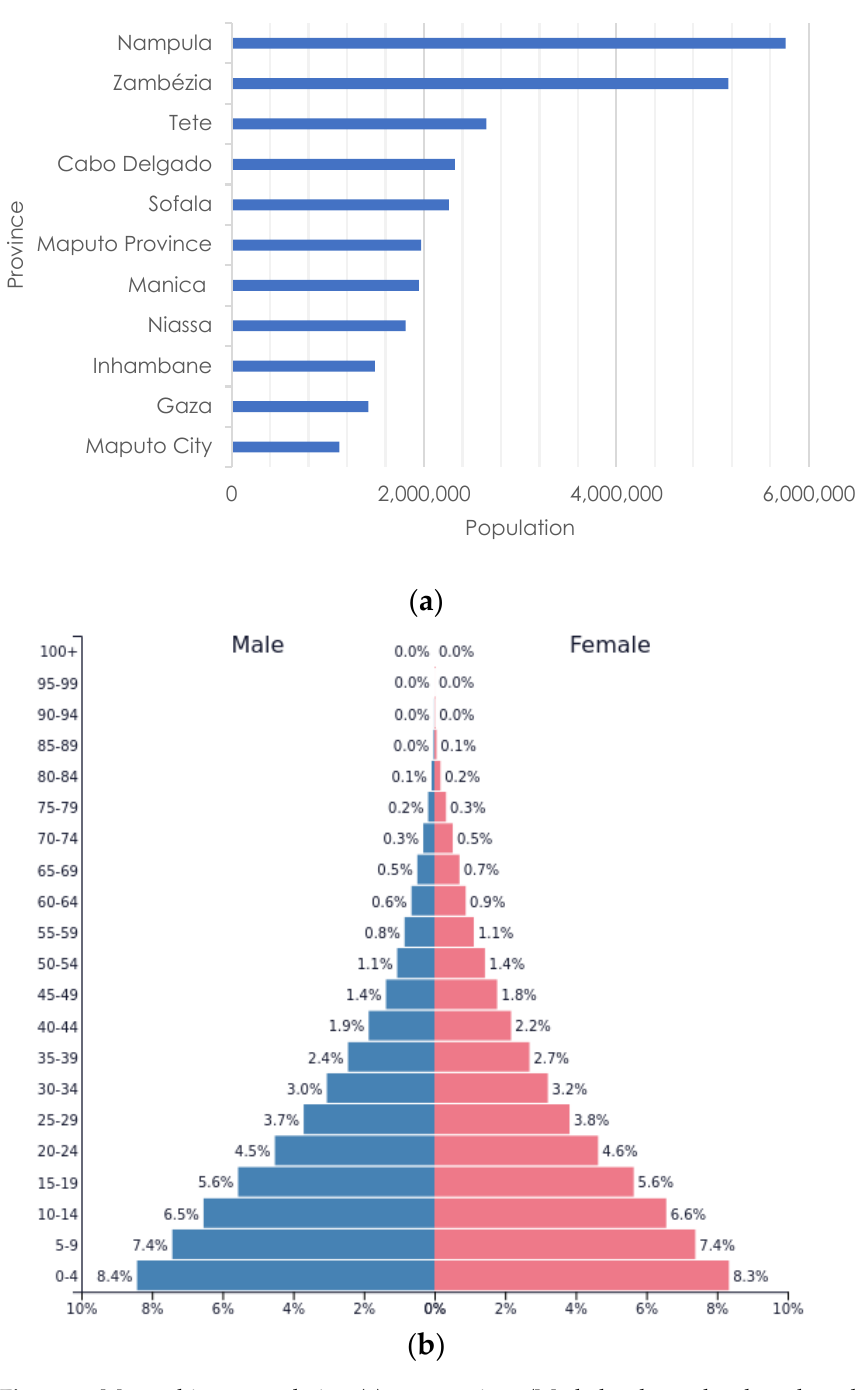
Figure 3. Mozambican population ( a ) per province (Made by the author based on the data from INAGE [61]) and ( b ) age pyramid (source: PopulationPyramid.net [62], under a Creative Commons license CC BY 3.0 IGO). According to the 2017 General Census, the estimated population is 29,496,008 [63].